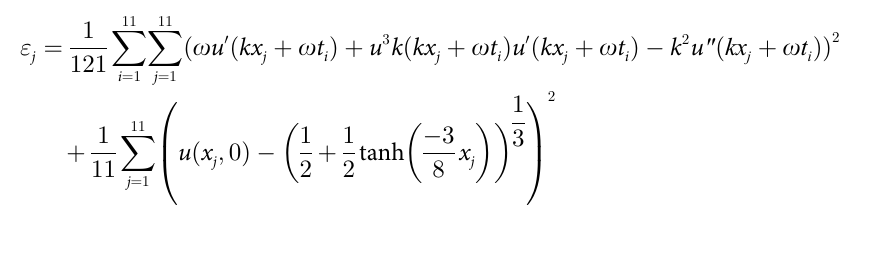
The approximate solution is obtained by the proposed scheme for three different values of δ We assume the solution is expressed by Exp-function method given by Equation (20). The fitness function is developed for each value of δ with β = 0 and α = 1. For example, the fitness